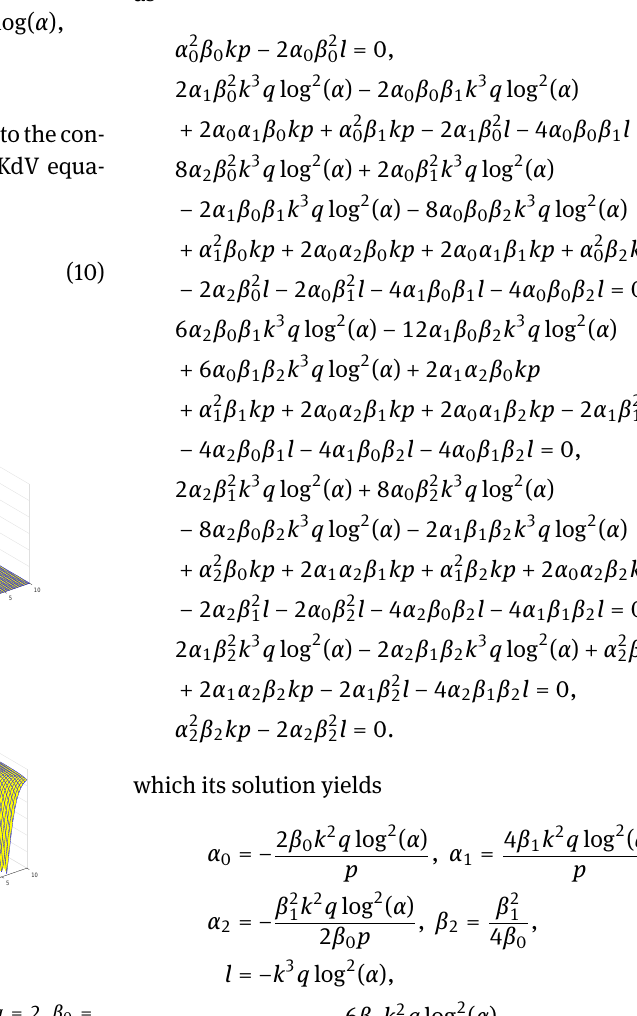
Fig. 1: Solution profile of U 1,2 corresponding to p = 3, q = 2, β 0 = 1 = β 1 and α =